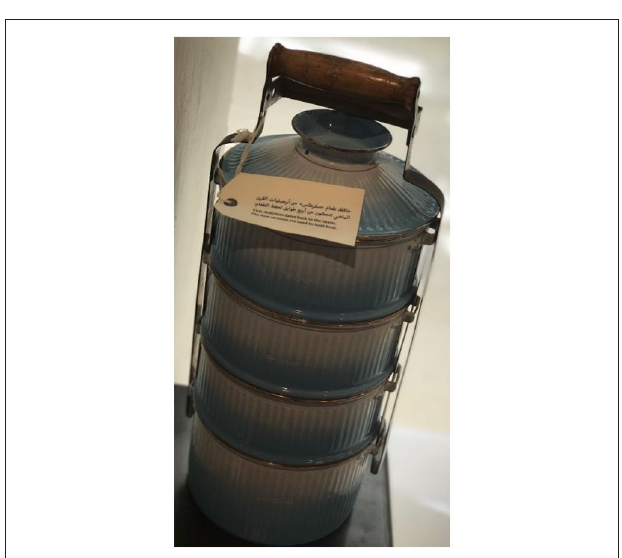
FIGURE 7 | A lunch box of four containers, used by Qatari laborers to preserve their food at their